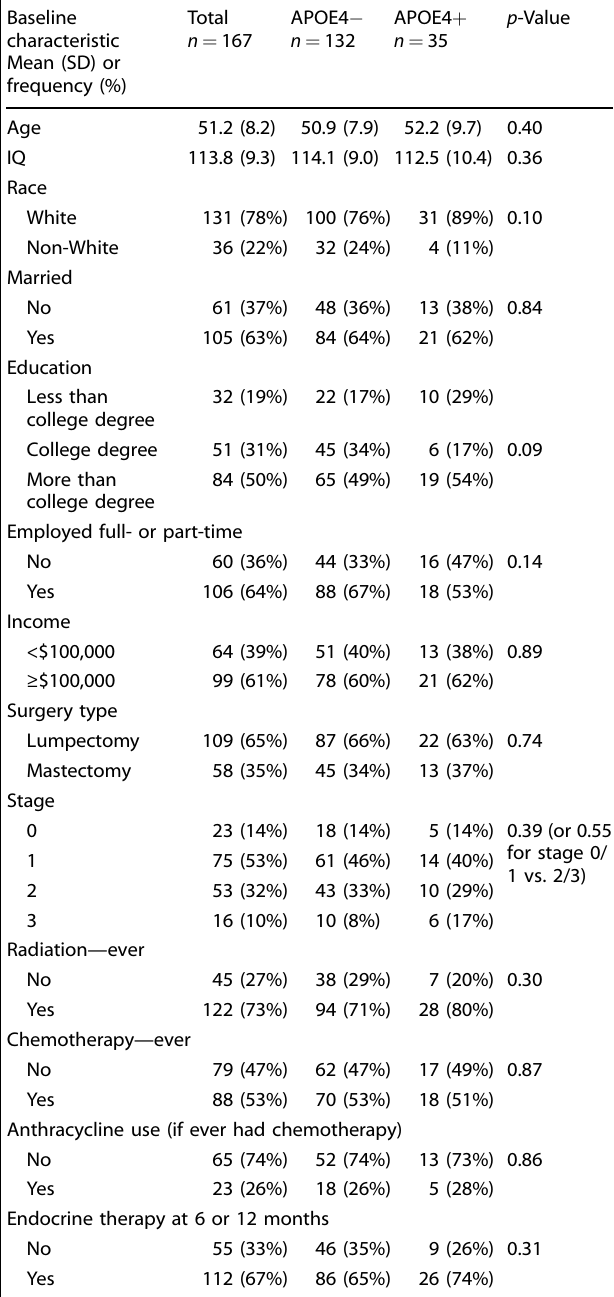
Table 1. Demographic and clinical characteristics of sample based on APOE4